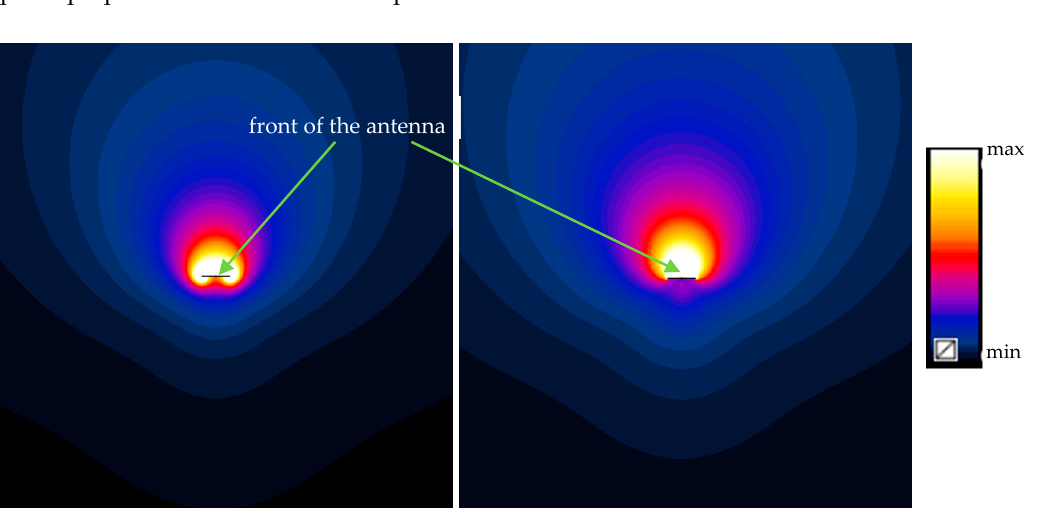
Figure 4. Magnetic ( left , min–max: 0.0004–0.4 A/m) and electric ( right , min–max: 0.01–100 V/m) field distribution in a plane perpendicular to the UHF RFID gun antenna plane at a radiated power of 1 W.